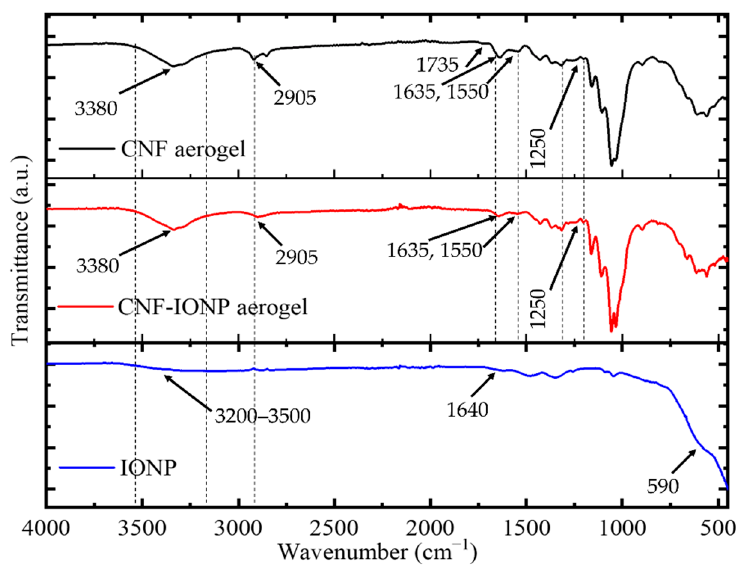
Figure 8. FTIR spectra for freeze-dried IONP, crosslinked CNF, and CNF-IONP aerogels.